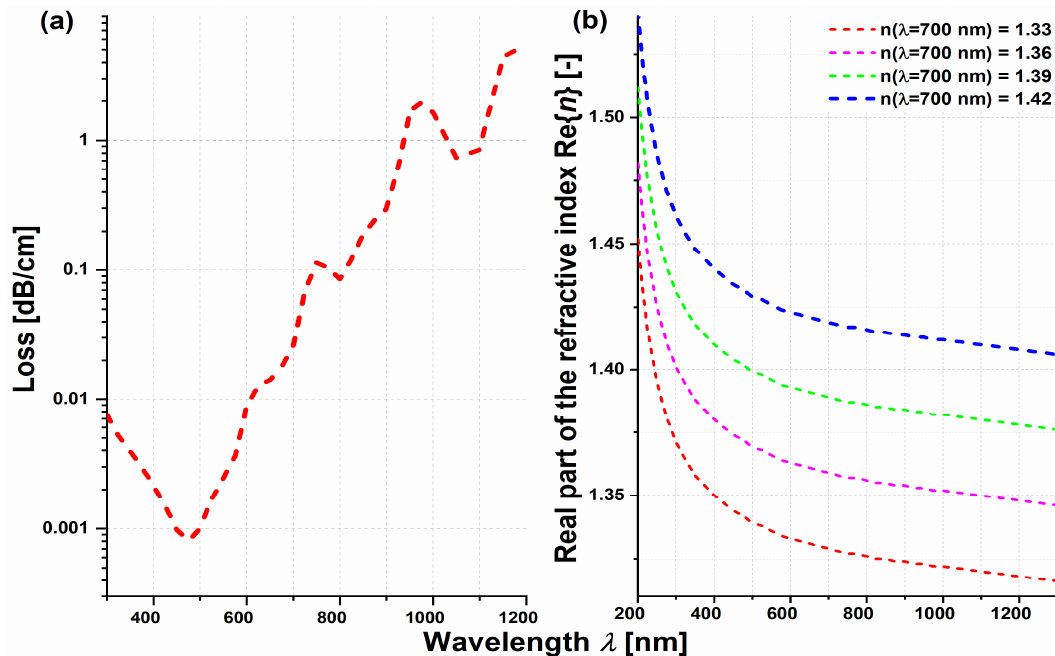
Figure A1. Loss spectra of pure water ( a ) and dispersion curves of aqueous sample models ( b ). The dispersion curves were calculated based on the real part of the refractive index of pure water (red dashed line).